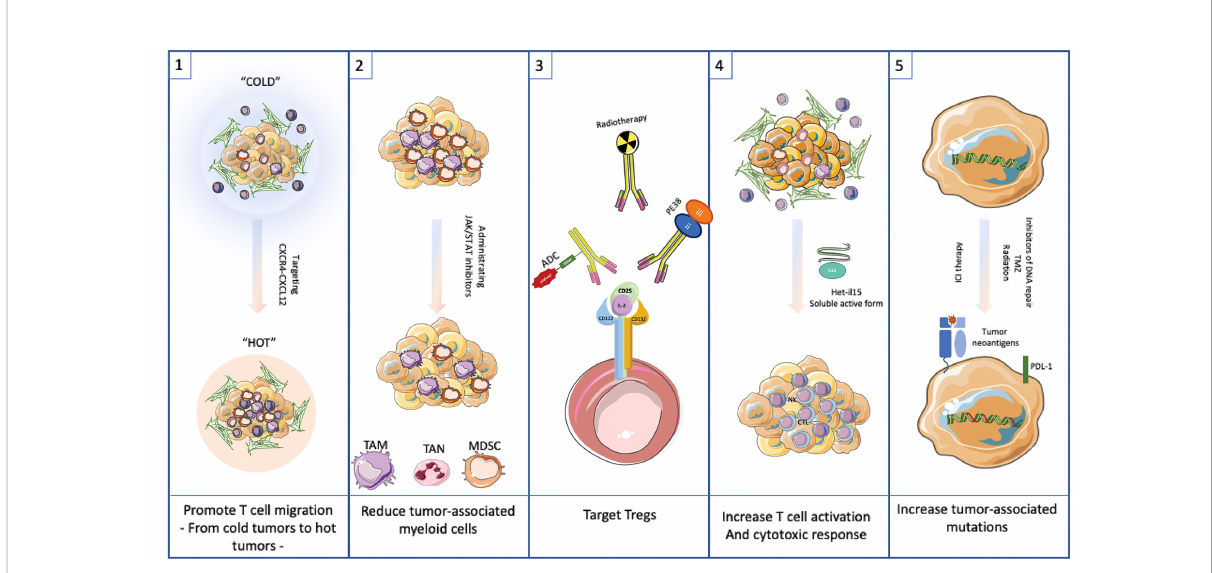
FIGURE 3 Targeting the TME as possible therapeutic approach. (1) Promote T cell migration into cold tumors by targeting CXCR4-CXCL12 interaction. (2) Reduce tumor-associated myeloid cells by using JAK/STAT inhibitors. (3) Target Tregs with antibodies to CD25 or similar surface antigen. (4) Increase T cell activation by adding Het-IL15. (5) Increase tumor-associated mutations by administrating inhibitors of DNA repair, TMZ or radiation to allow neoantigens to drive a robust immune